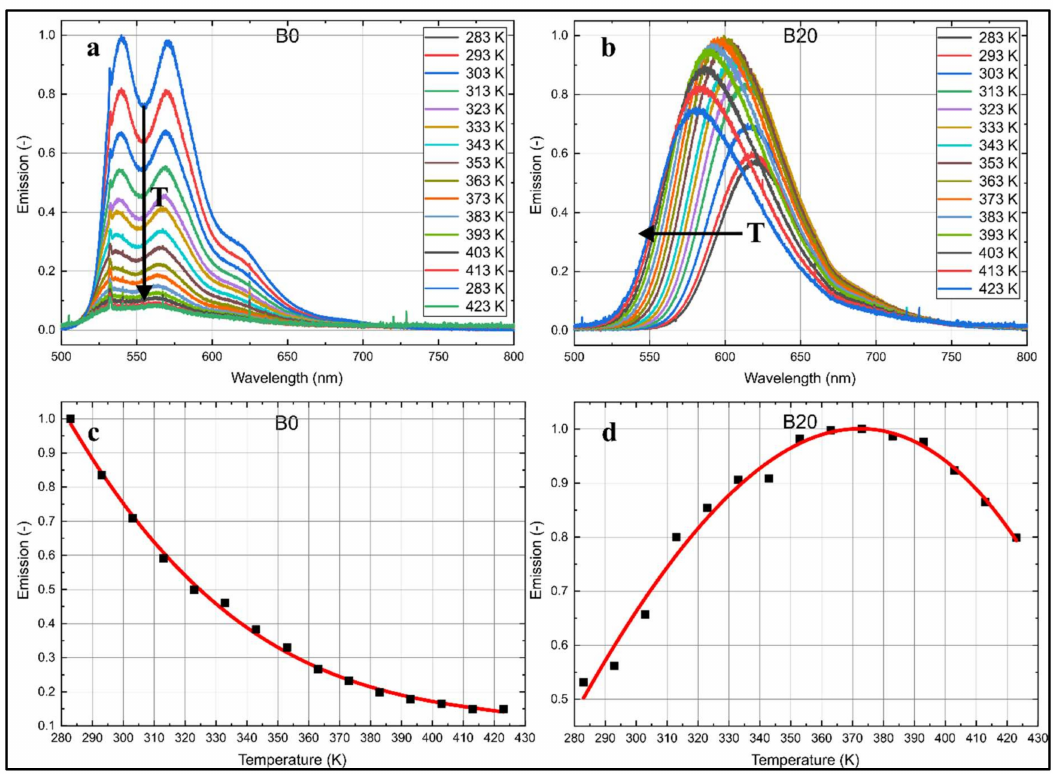
Figure 5. Temperature-dependent normalized emission spectra of nile red (7.5 mg / L) in B0 ( a ) and B20 ( b ) normalized to the individual maximum intensity; normalized integral fluorescence intensities ( c : B0, d : B20) for various temperatures.